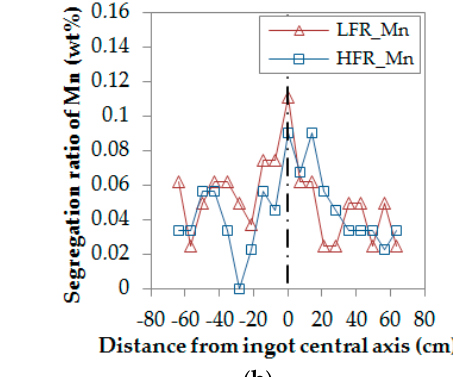
Figure 4. Segregation ratio profiles along the ingot central axis of the two ingots: ( a ) carbon; ( b ) manganese; ( c ) chromium.